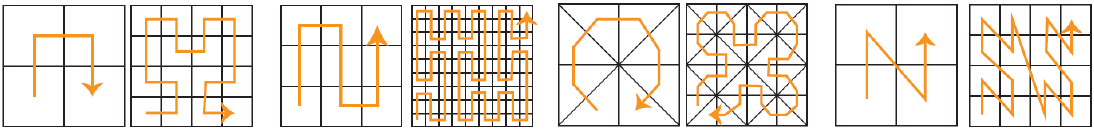
Figure 3. From left to right, Hilbert, Peano, Sierpinski and Morton space filling curves. The order